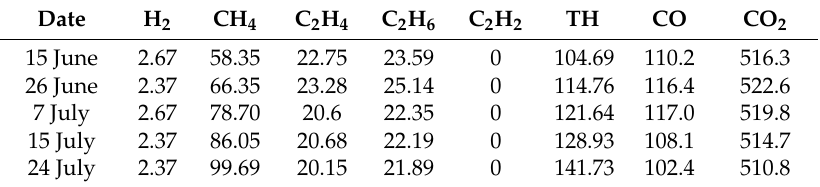
Table 5. Oil chromatography online monitoring data for the 220 kV #1 transformer (units: µ